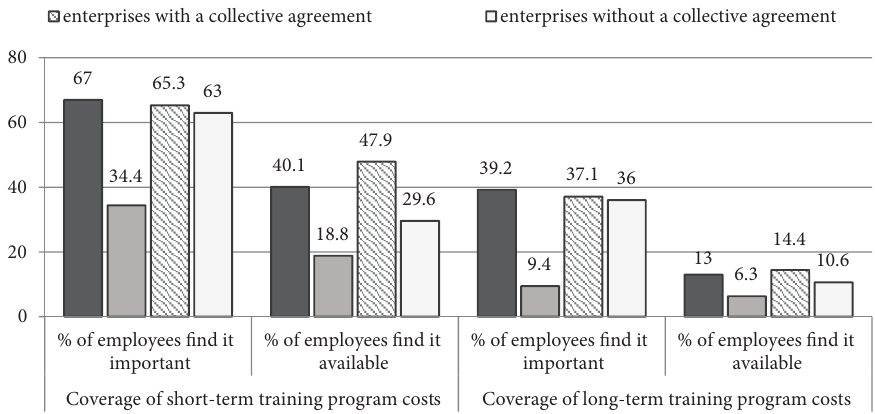
Figure 2. The importance and availability of training programs for employees of enterprises with different indicators of profitability and the existence of collective